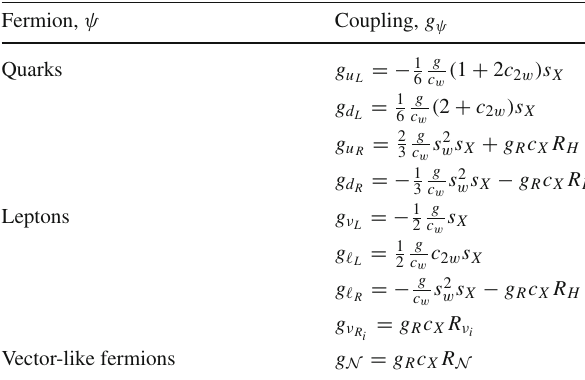
Table 2 Couplings of the fermions with the new gauge boson. Here we use the notation: c 2 w = cos ( 2 θ w ) . N L , R is any vector-like fermion singlet under the SM and carries R N charge under U ( 1 ) R . If a model does not contain vector-like fermions, we set R N = 0 Fermion, ψ Coupling, g